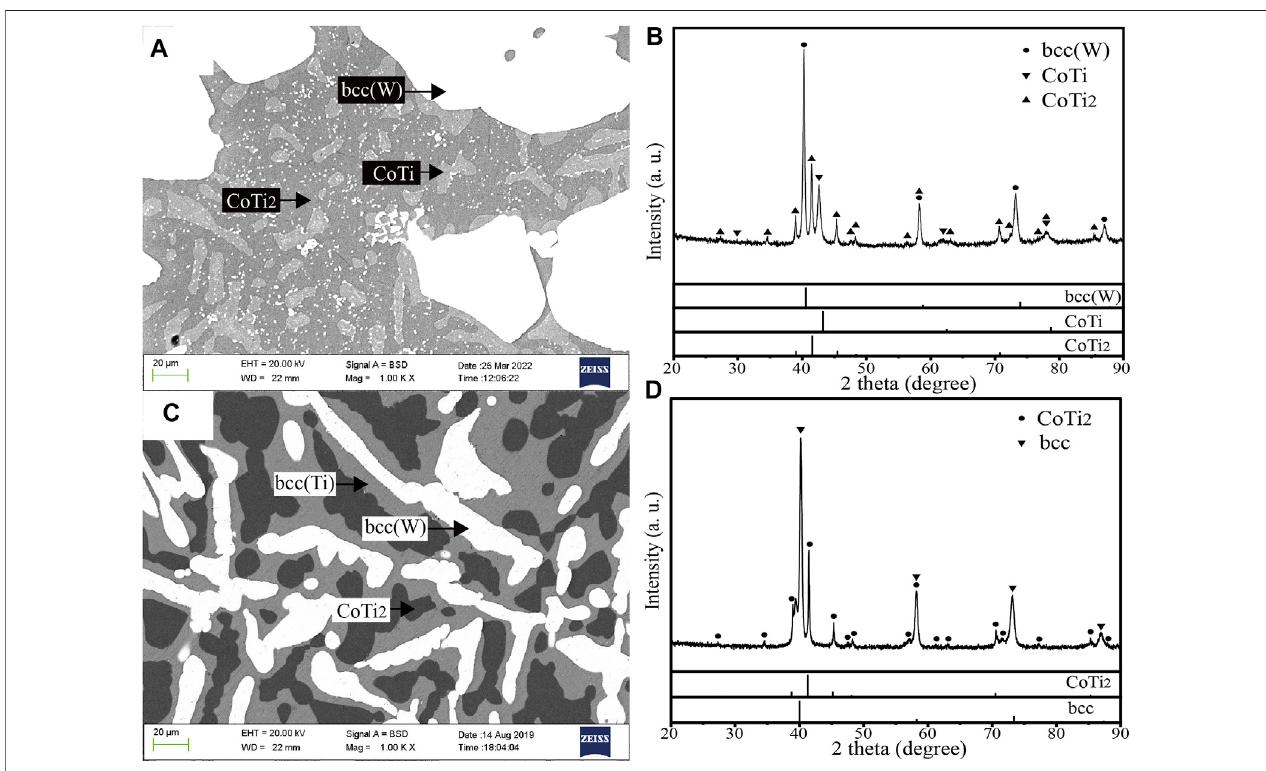
FIGURE 5 | BSE micrographs and XRD patterns of alloys (A) and (B) for a11 (C) and (D) for a12.